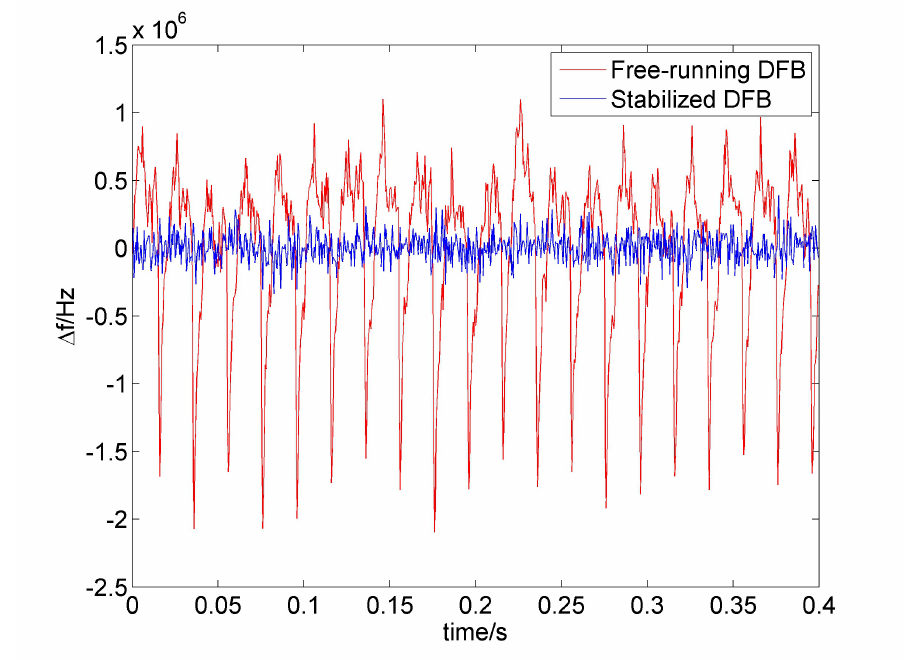
Figure 4. Temporal evolution of the beat frequency between the stabilized optical frequency comb and free-running DFB laser (red) and between the stabilized optical frequency comb and the noise suppressed DFB laser